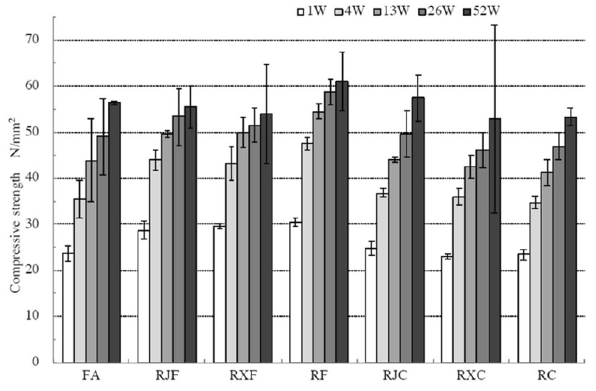
Fig. 17 Compressive strength with a W/B of 0.5 in Series